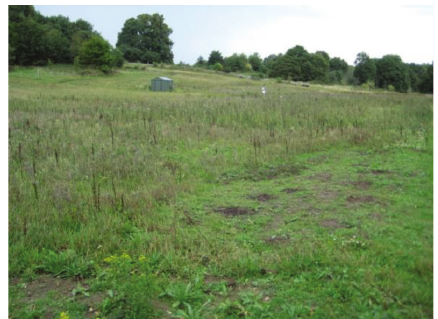
Figure 6: Picture of site 1. Samples were collected near the bottom right hand corner of the photo.